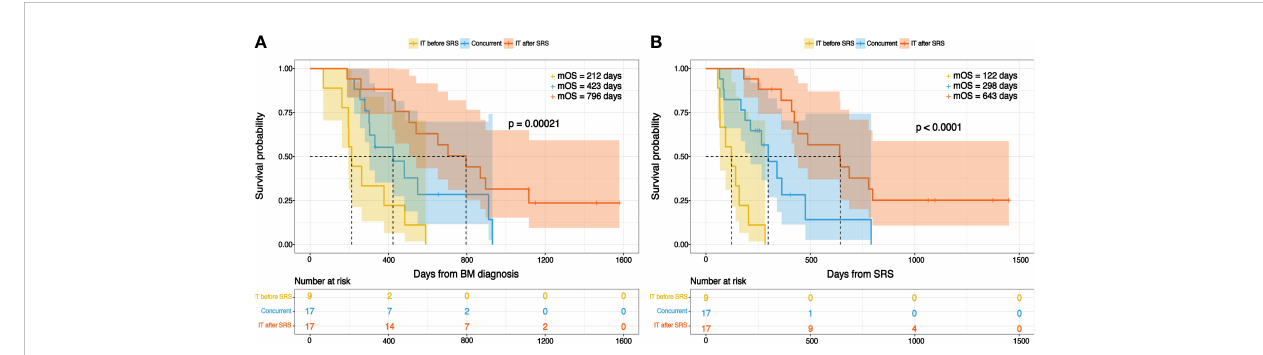
FIGURE 2 Overall survival with reference to immunotherapy timing from the day of (A) BM diagnosis (B)